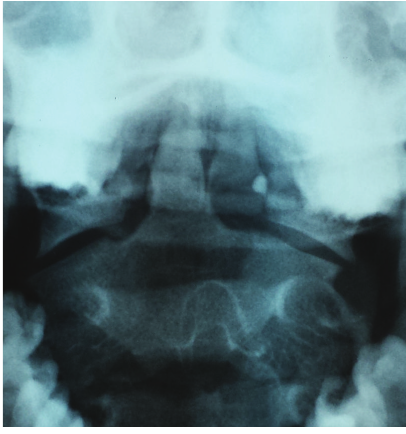
Figure5: AP “openmouthview” afterremoving “halo-vest”system.